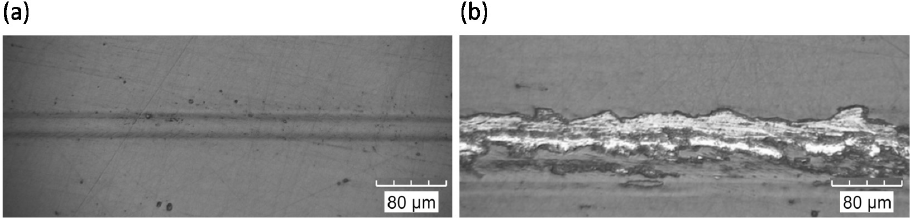
Figure 4. Optical Microscopy scans of the wear trace during ( a ) coating wearing phase; ( b ) coating failure phase.